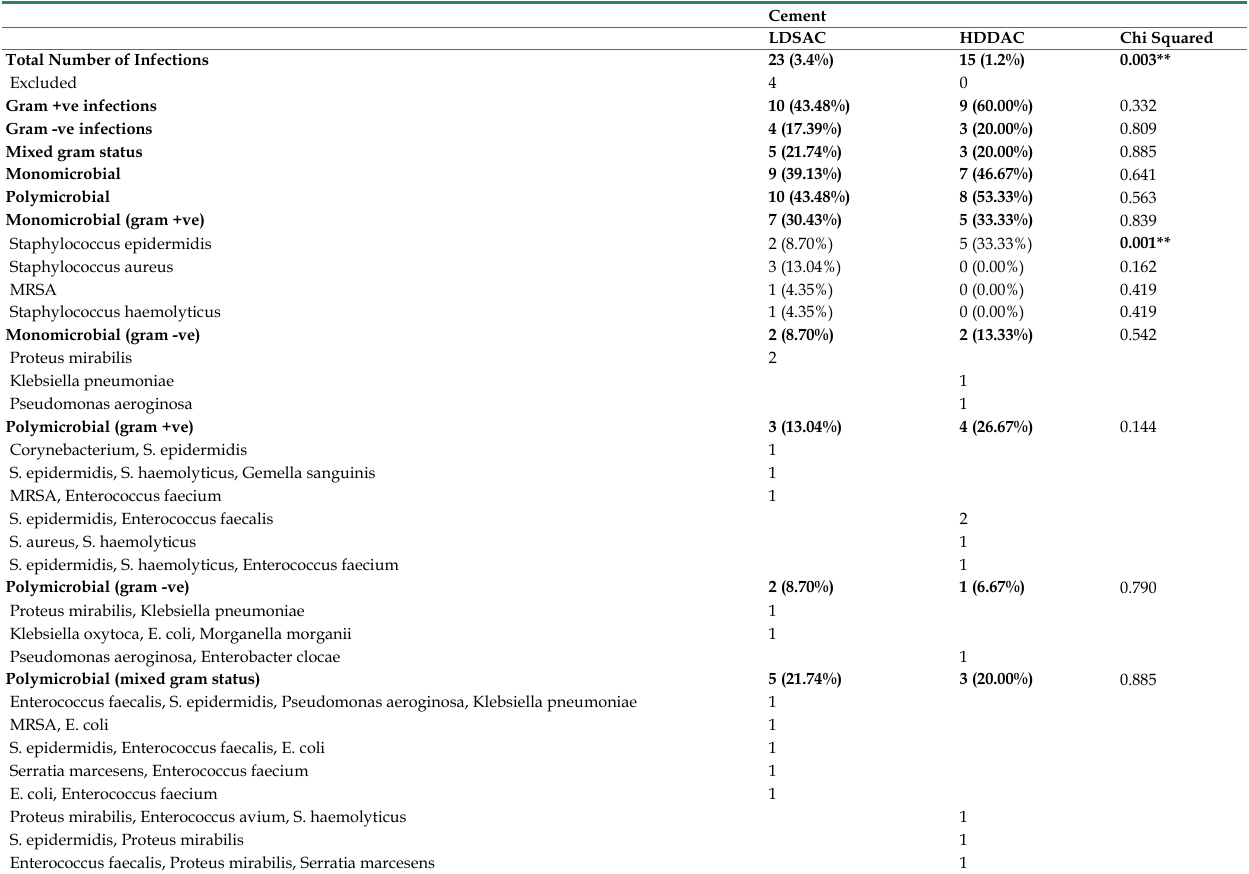
Table 1. Breakdown of causative organisms in isolated